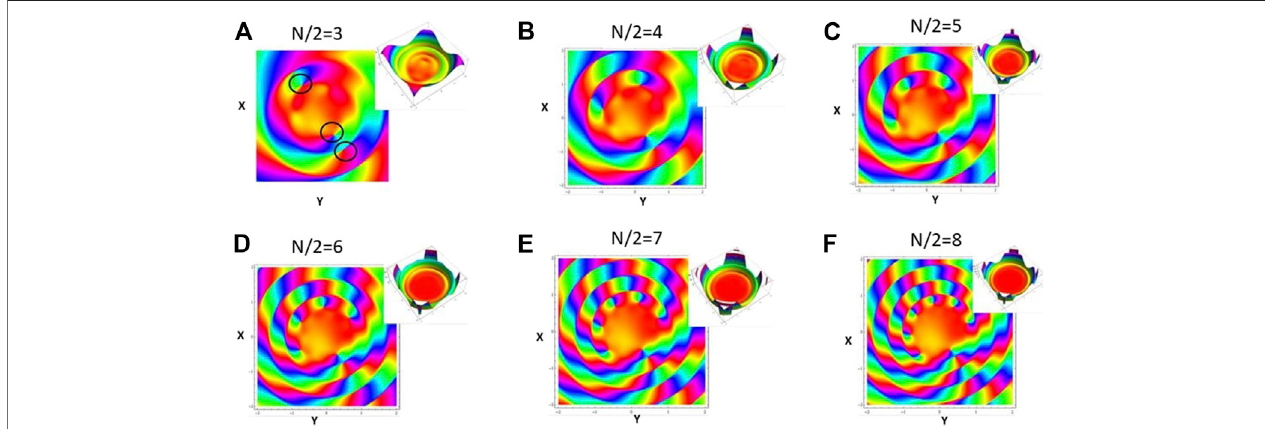
(cid:5)(cid:5)(cid:5)(cid:5) (cid:5)(cid:5)(cid:5)(cid:5) ( x , y ) ϕ FIGURE3| Phasepro fi le ofresultingLaguerre-Gaussquadraturerepresentationforasqueezingparameter r (cid:3) 0 . 02,exploringtheimpactofthephoton- LG number ( N / 2 per mode) in the formation of vortices. Insets correspond to amplitude plots input photons. (A) N / 2 (cid:3) 3, (B) N / 2 (cid:3) 4, (C) N / 2 (cid:3) 5, (D) N / 2 (cid:3) 6, (E) N / 2 (cid:3) 7, (F) N / 2 (cid:3) 8, with N / 2 input photons per mode (see text for